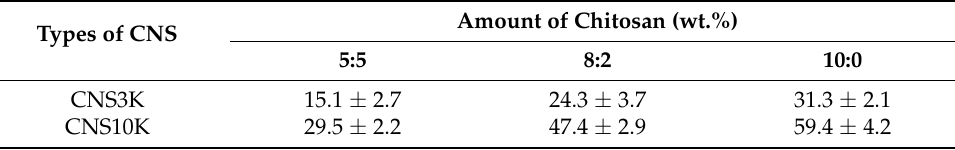
Table 1. Amount of chitosan in chitosan nanosponges (CNS3Ks and CNS10Ks) with different ratios of chitosan as analyzed using a ninhydrin